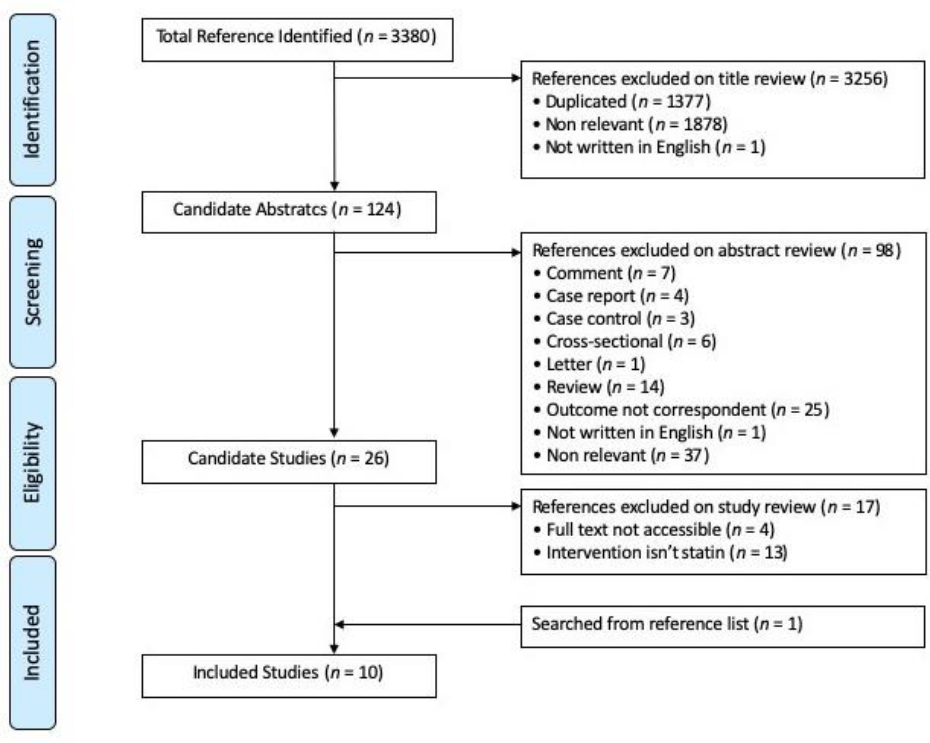
Figure 1. PRISMA flow chart.